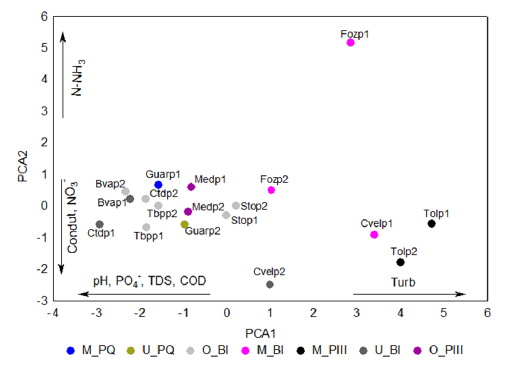
Figure 2. Principal Component Analysis (PCA) for the environmental variables analyzed in the rivers of the three